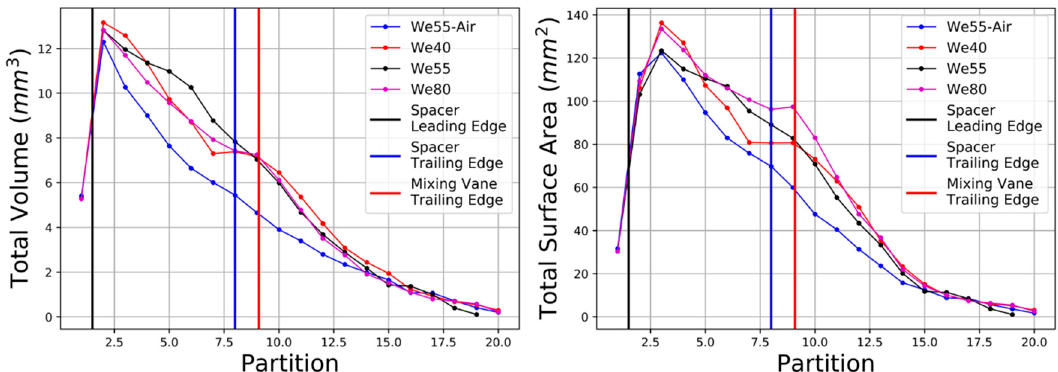
Figure 19. Axial profile of time-averaged droplet volume ( left ) and surface area ( right ) in domain partitions for all two-phase cases.